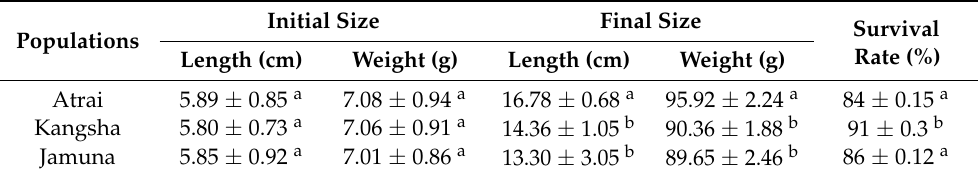
Table 2. Growth response and survival rate of three river populations of Ariza labeo ( L. ariza ) during the 12 months domestication period † .